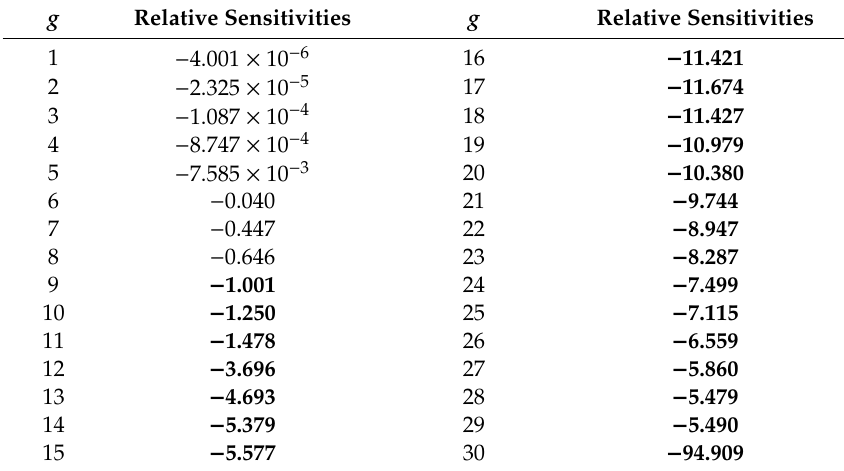
Table 5. Second-Order Relative Sensitivities S ( 2 ) g Relative Sensitivities g Relative Sensitivities